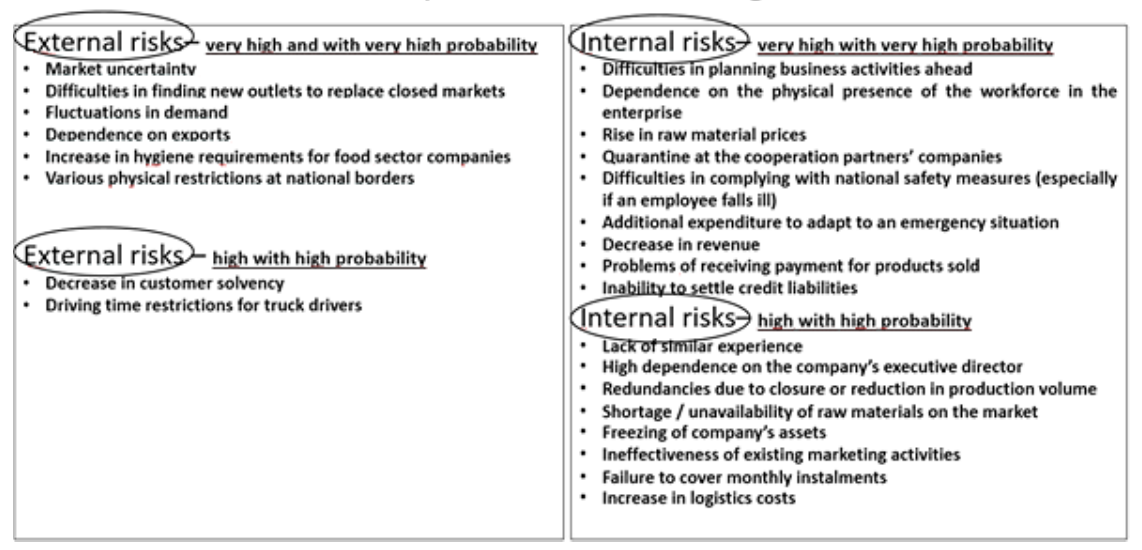
Figure 5. Summary of Latvia’s meat sector risks during and after COVID-19